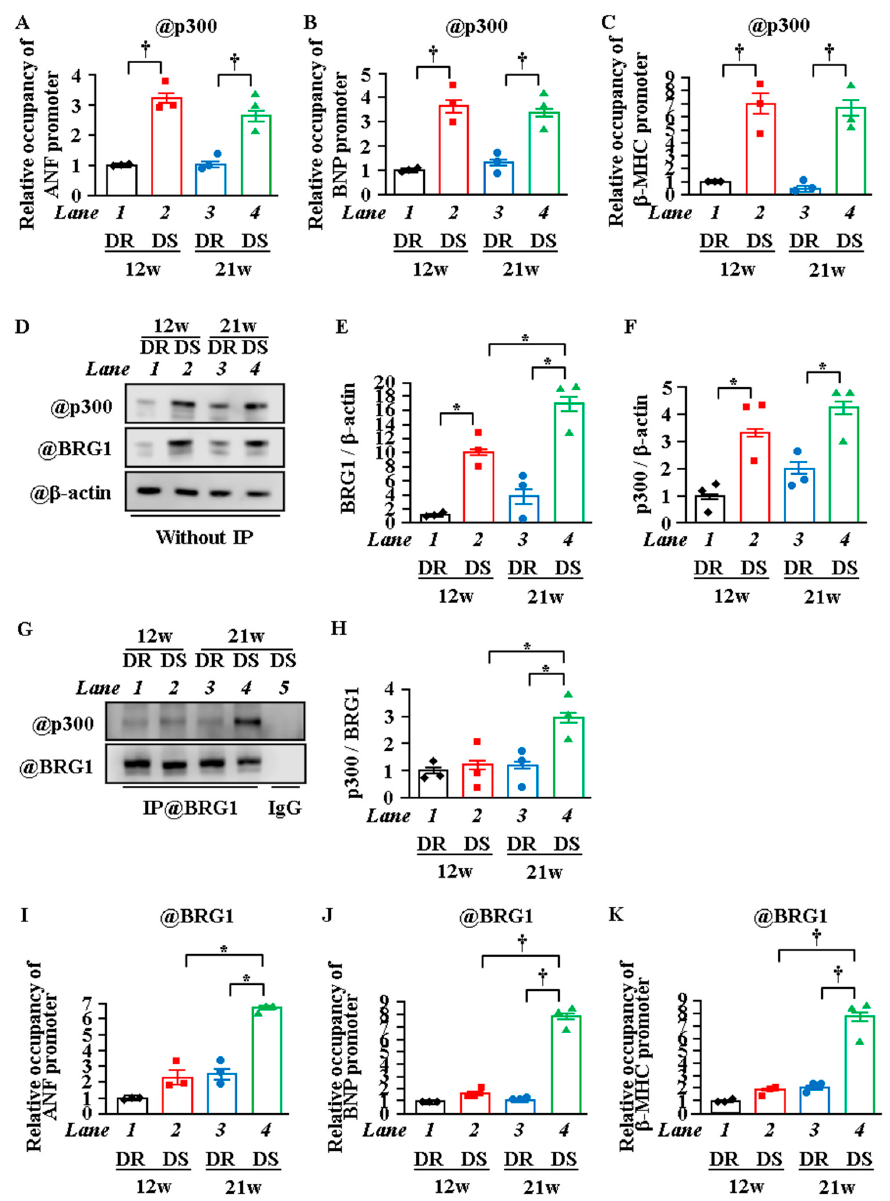
Figure 5. The interaction between p300 and BRG1 was increased in the HF stage. ( A – C ) In vivo ChIP assay was performed using the heart lysates of DR and DS rats at 12 or 21 weeks of age with anti-p300 antibody ( A – C ) or normal rabbit IgG as a negative control (not detected). ( D – F ) Nuclear proteins were extracted from the hearts of DR or DS rats at 12 or 21 weeks of age. ( D ) is a photograph of a representative Western blot, and ( E and F ) are a quantification of ( D ). ( G , H ) Dahl rat heart lysates were used for immunoprecipitation with either control rabbit IgG or BRG1 antibody. Immunoblots were performed for p300 and BRG1. ( G ) is a photograph of a representative Western blot, and ( H ) is a quantification of ( G ). ( I – K ) In vivo ChIP assay was performed using heart lysates of DR or DS rats at 12 or 21 weeks of age with anti-BRG1 antibody or normal rabbit IgG as a negative control (not detected). ( A – C , E , F , H – K ), N = 3; two-way ANOVA followed by Tukey test. * p < 0.05, † p < 0.01.